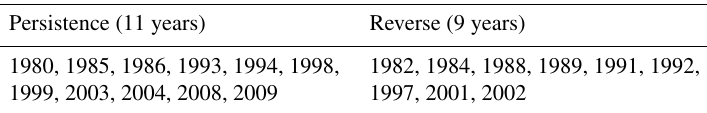
Table 1. Lists of the persistent and reverse